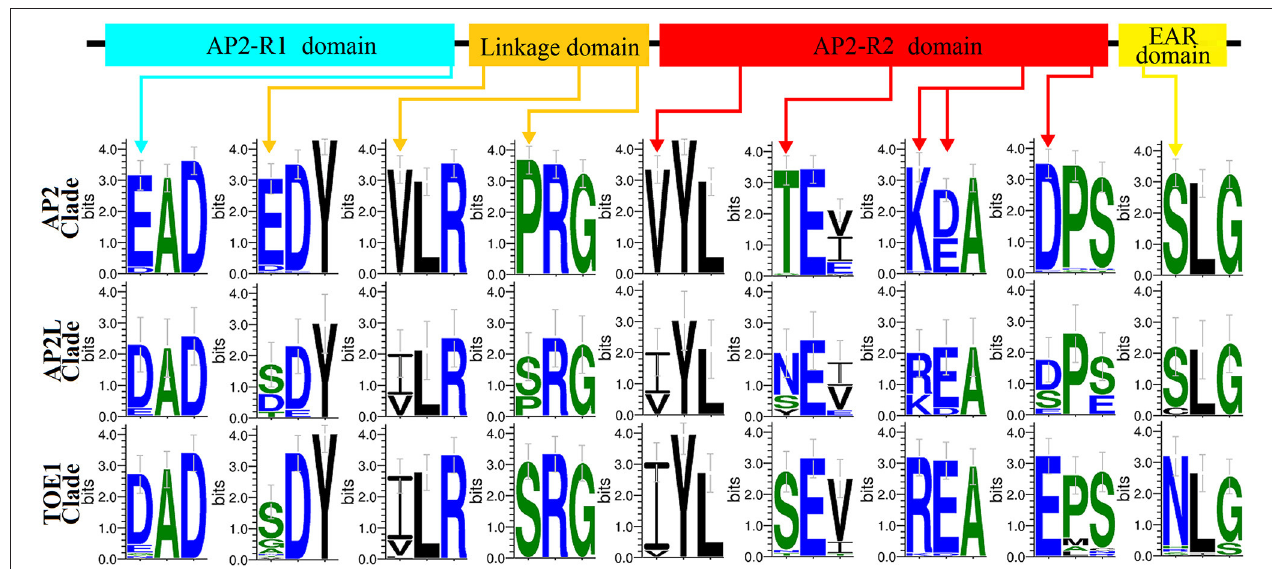
FIGURE 5 | Clade-specific sites in Homeodomains among Three Clades Genes (AP2 clade,AP2L clade, and TOE1 clade). Sequence logos of clade-specific sites in homeodomains identified in AP2Ls, AP2s, and TOE1s sequences. The arrows marked clade-specific sites and their position in homeodomains.